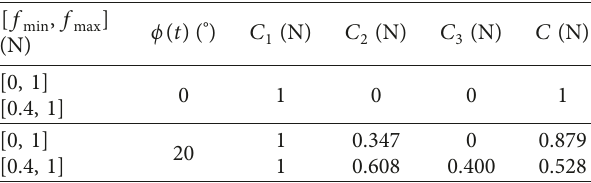
Table 2: Calculated values of the equivalent contact